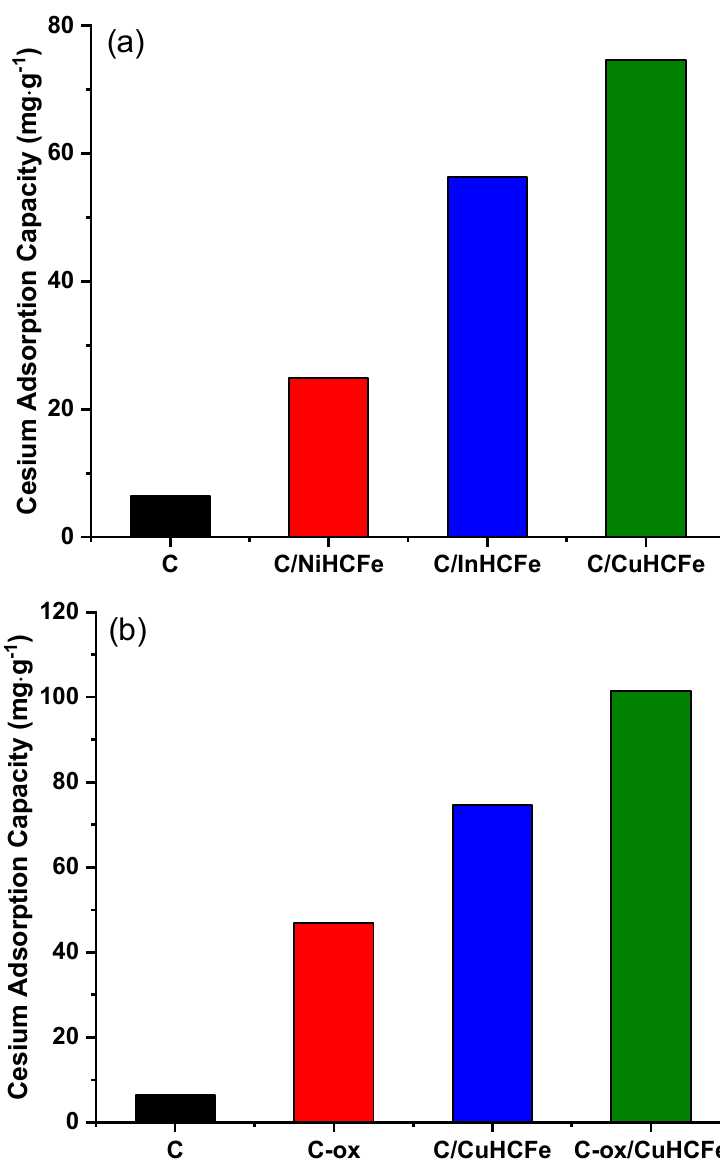
Figure 5. Cesium adsorption capacities measured with atomic absorption spectroscopy on ( a ) three C / MHCFe nanocomposites and the C reference, and ( b ) both pristine and oxidized carbon supports and their corresponding CuHCFe nanocomposites.